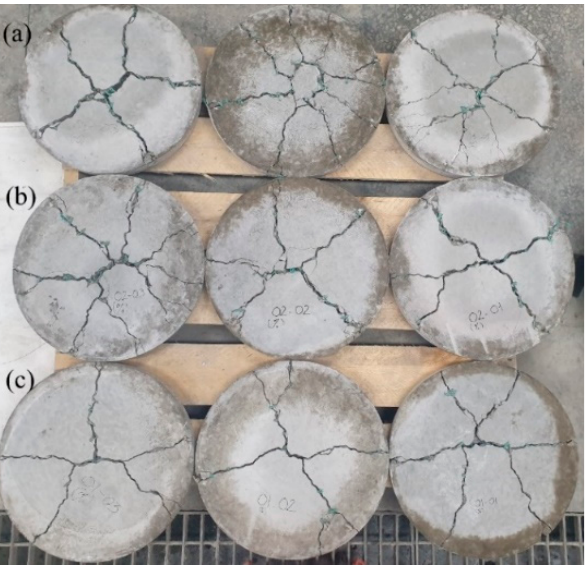
Figure 9. Tensile fiber of round panel concrete samples: ( a ) WFN samples with fiber-reinforced concrete proportions of ( a ) 3%; ( b ) 2%; ( c ) 1%.